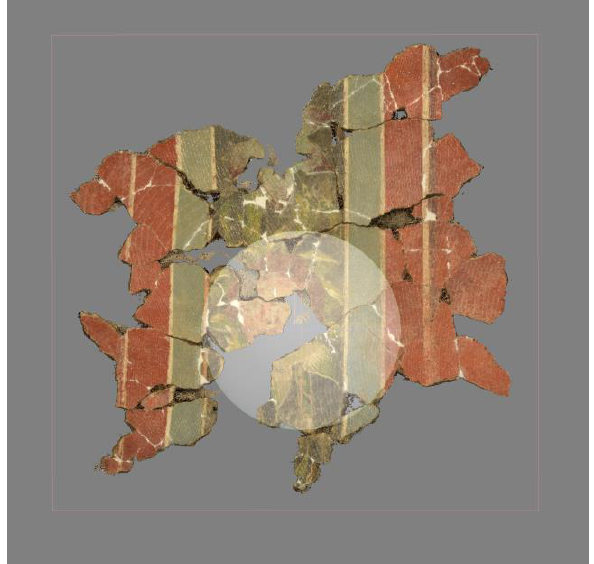
Figure 3. Dense point cloud of one of the fragments from the